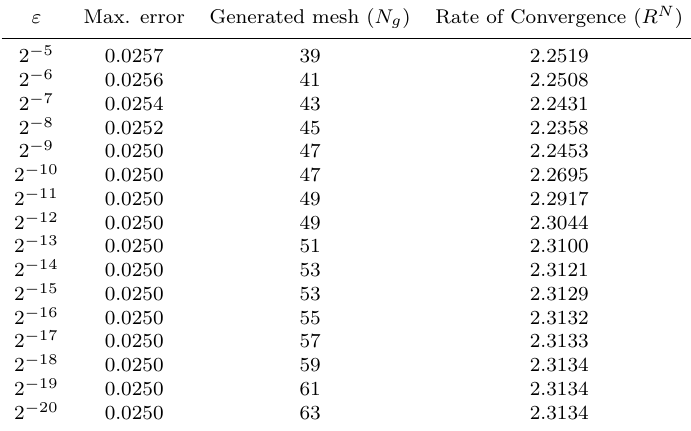
Table 2. Maximum absolute error for Example 2 for different values of ε with N = 23 (initially) ε Max. error Generated mesh ( N g ) Rate of Convergence ( R N